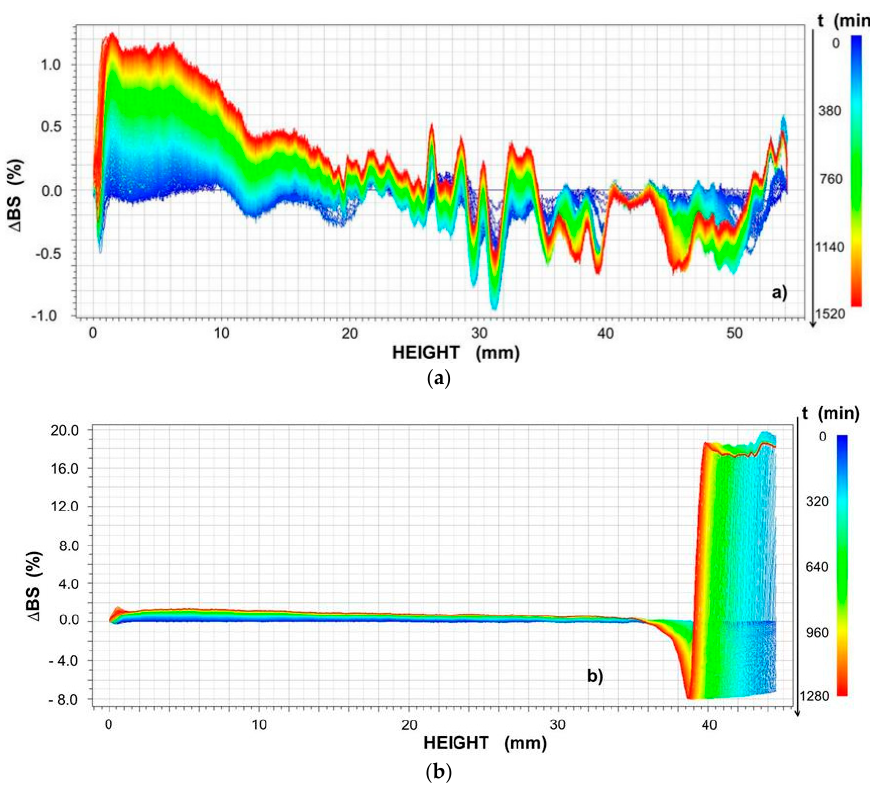
Figure 5. ( a ) Backscattering ( BS ) percentage of C1(1) sample; and ( b ) of C1(2) sample.